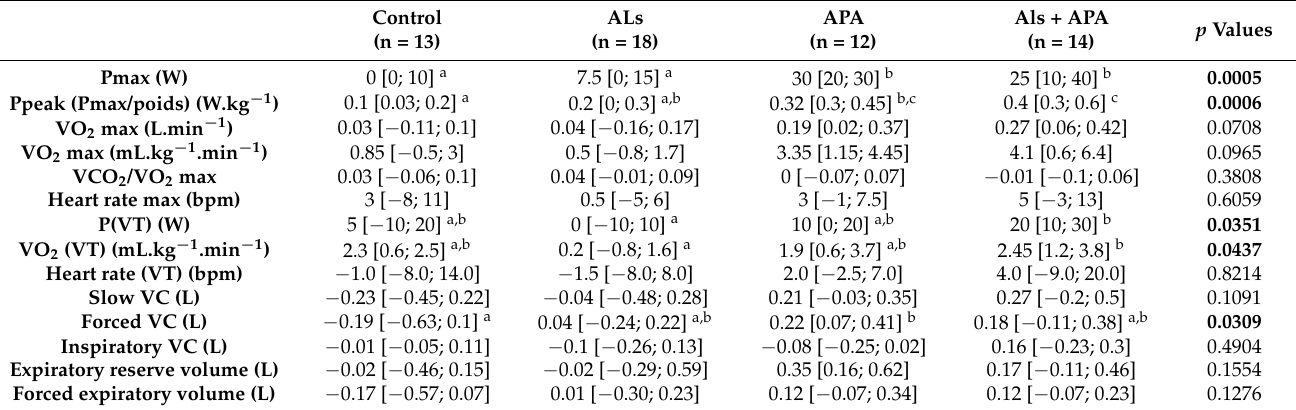
Table 4. Changes in the CPET observed after 6 months of treatment: delta